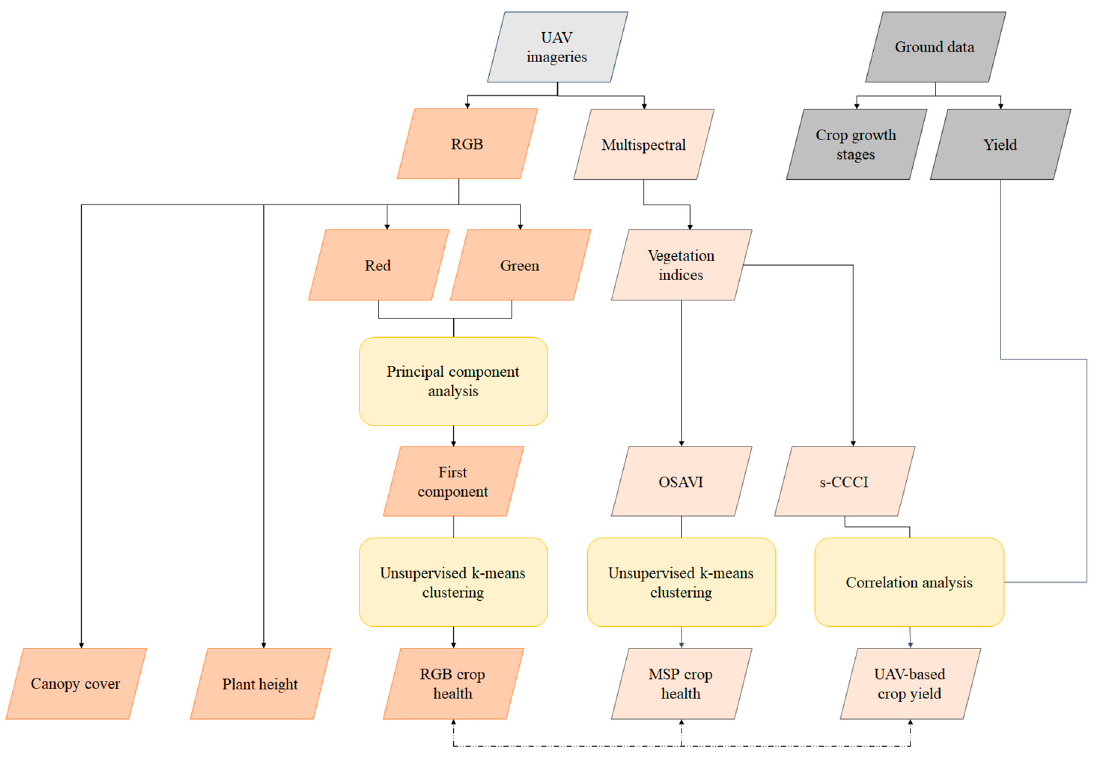
Figure 2. Methodological flowchart for crop traits retrieval from the unmanned aerial vehicle (UAV) imageries in combination with ground-based data. Table 1. An overview of the data acquisition using the unmanned aerial vehicles within the 2019 growing season. Flight times (start time–end time) are expressed in local time.